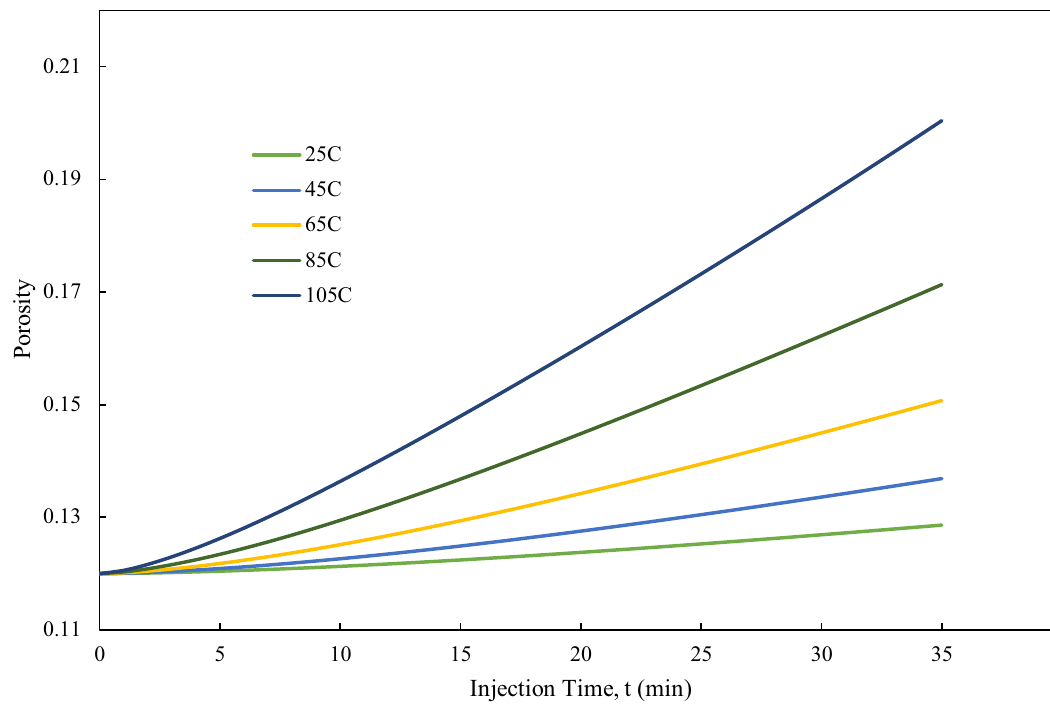
Fig. 6 The effect of temperatures on sandstone porosity after fluoroboric